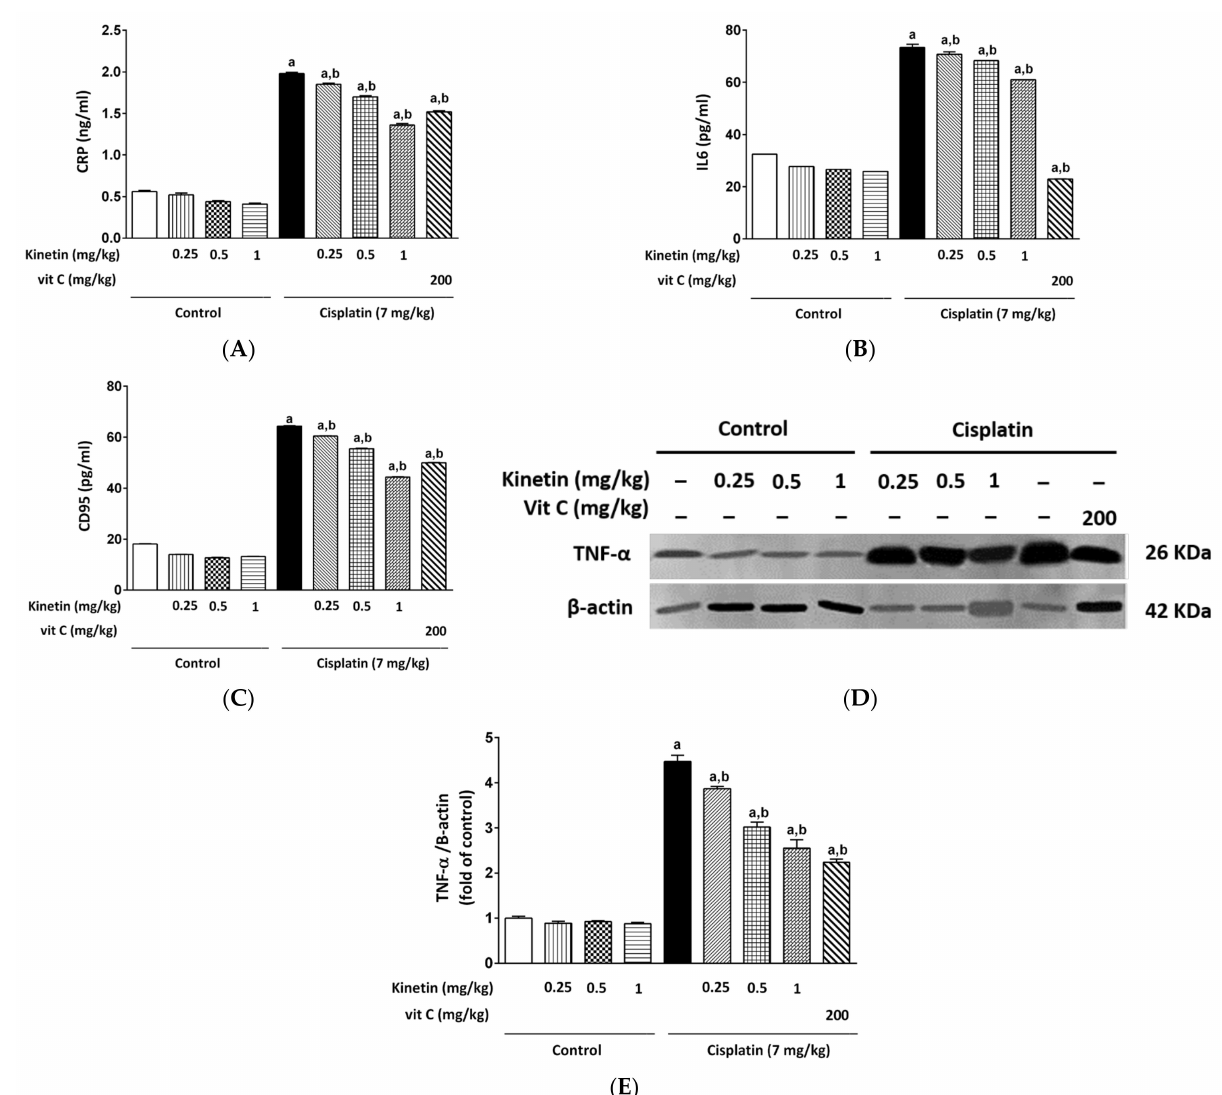
Figure 5. Effect Effect of kinetin on inflammatory status in isolated lymphocytes. Effect of different doses of kinetin and vitamin C on ( A ) CRP, ( B ) IL6 and ( C ) CD95. ( D ) Western blot analysis showing effect of different doses of kinetin and vitamin C using TNF- α Ab together with β -actin Ab as an internal control showing strong activation of TNF- α in CP-treated group ( n = 6). ( E ) Quantitative analysis (fold changes) of Western blots. a Significantly different from control group, b significantly different from cisplatin group according to one-way ANOVA followed by Tukey–Kramer multiple comparisons test at p < 0.01, ( n = 6). Tests were performed as described in Research Design and Methods. CRP: C-reactive protein, IL6: interleukin 6, CD95: cluster of differentiation, Vit C: vitamin